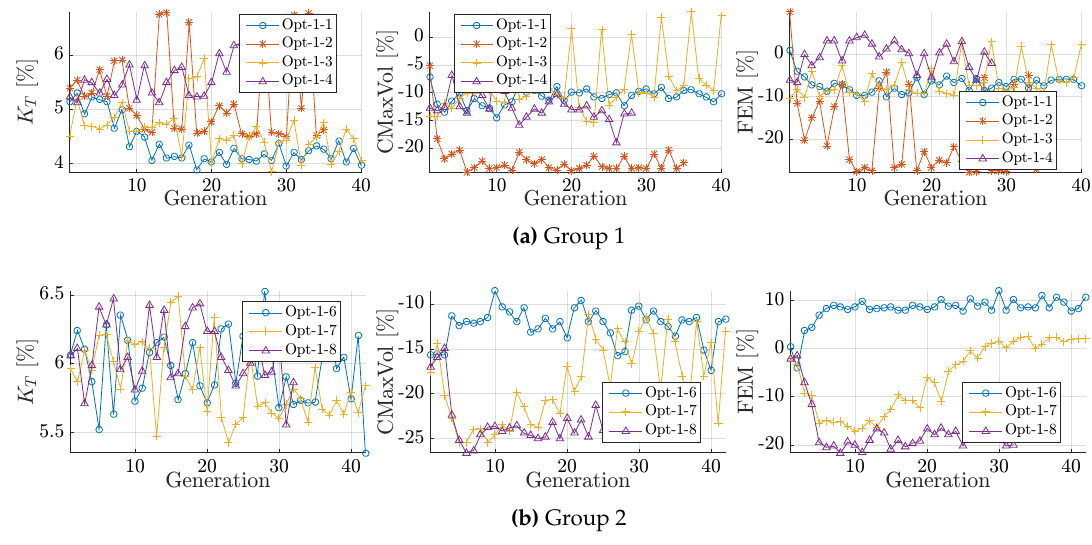
Figure 3. Development of the constraints, given as the generation median of K T , maximal cavity volume and blade strength, relative to baseline design; Opt-1. ( a ) Group 1; ( b ) Group